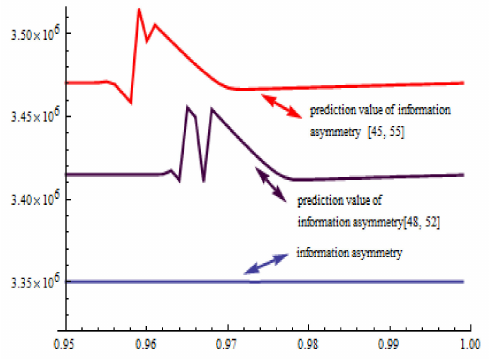
Figure 3. Trend chart of the expected revenue of the retailer.